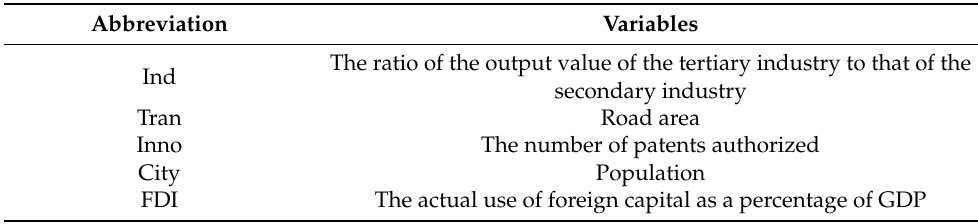
Table 2. Definitions of the socioeconomic